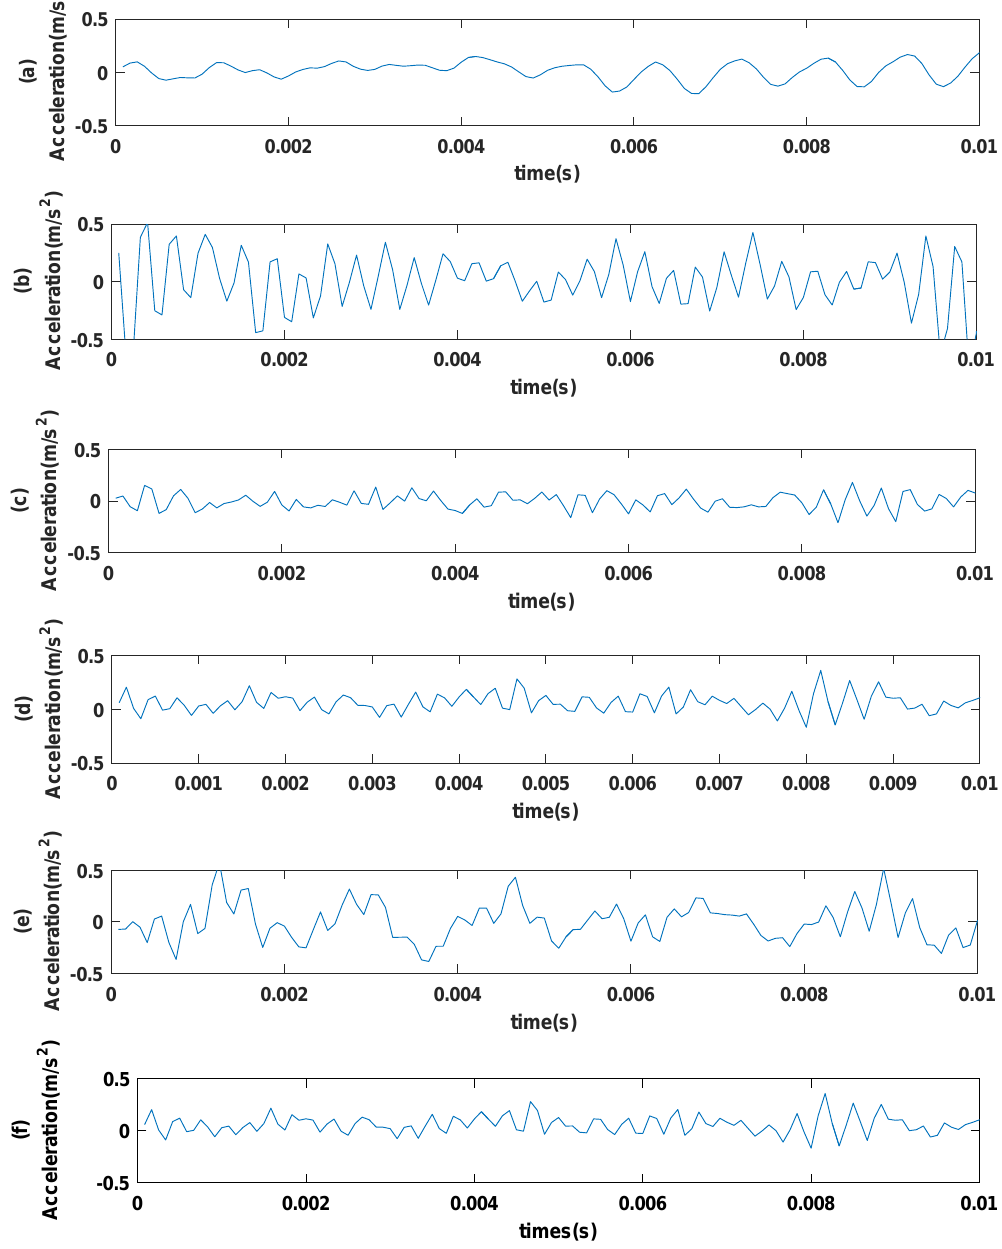
Figure 6. The time domain waveform of rolling bearings is shown in the figure. The x -axis is the time unit of the second and y -axis is the driving end bearing accelerator data. ( a ) normal bearing signal waveform; ( b ) inner fault signal waveform; ( c ) roller fault signal waveform; ( d ) outer fault signal waveform at center @6:00; ( e ) outer ring fault signal at orthogonal @3:00; ( f ) outer fault signal waveform at opposite